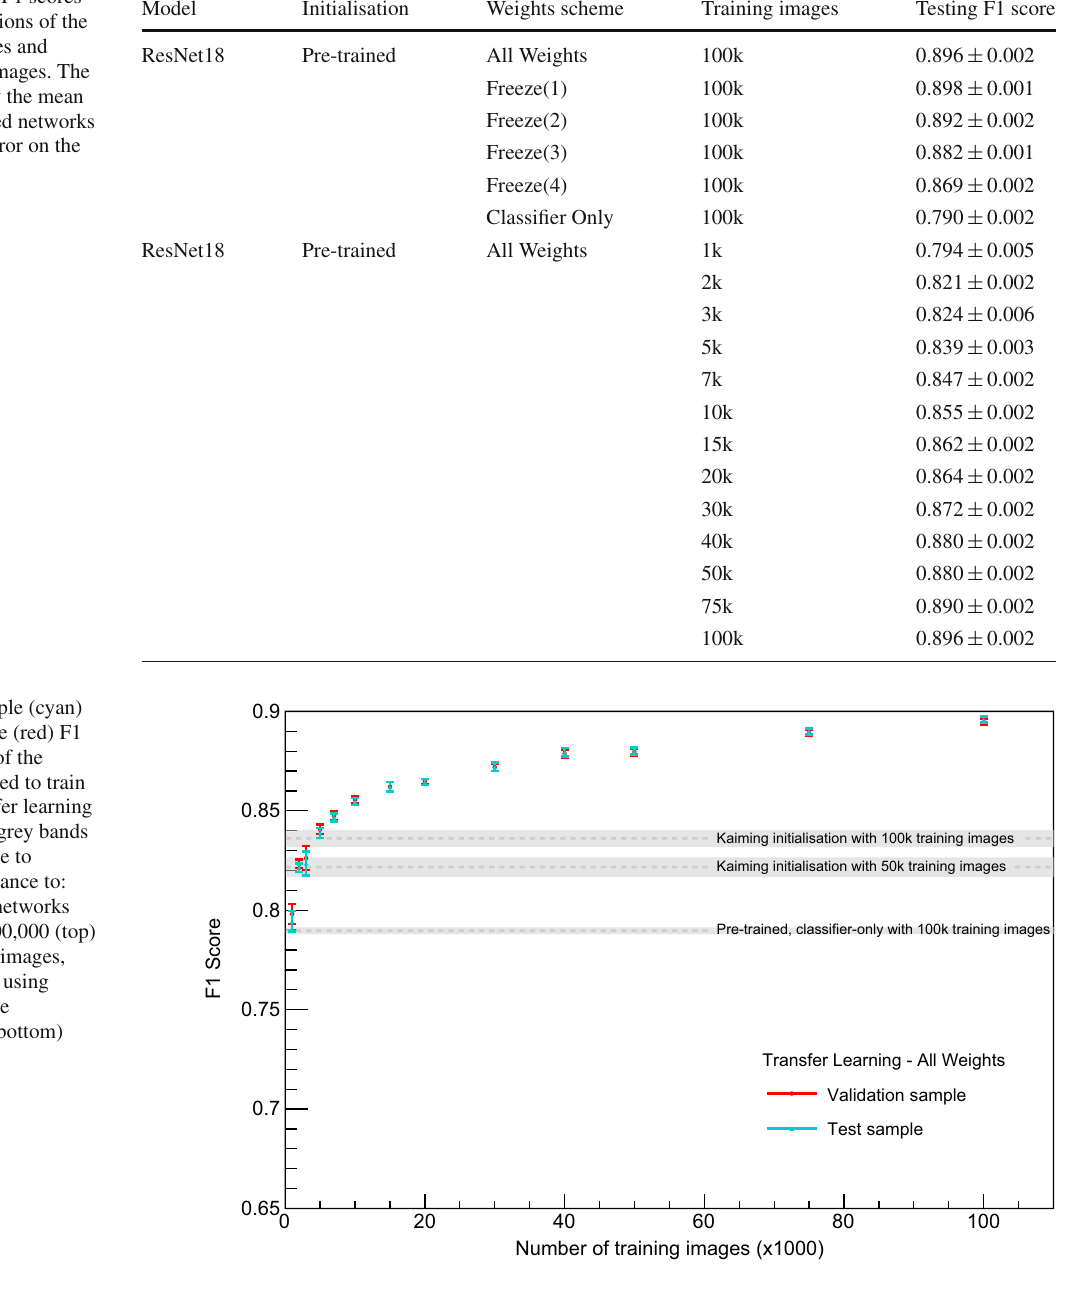
Table 2 The testing F1 scores for various combinations of the transfer learning cases and number of training images. The reported values show the mean value of the 25 trained networks and the associated error on the mean